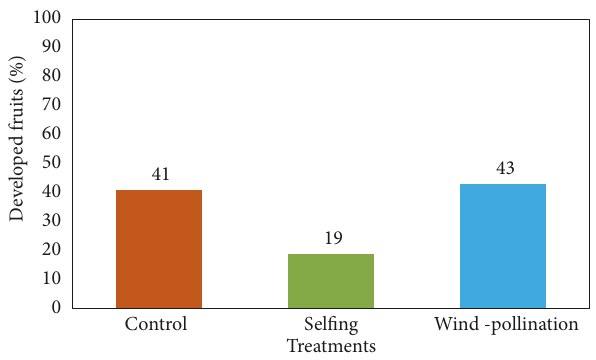
Figure 3: Proportion of fruits developed from selfing, controlled wind pollination, and natural pollination (control) in Marula.